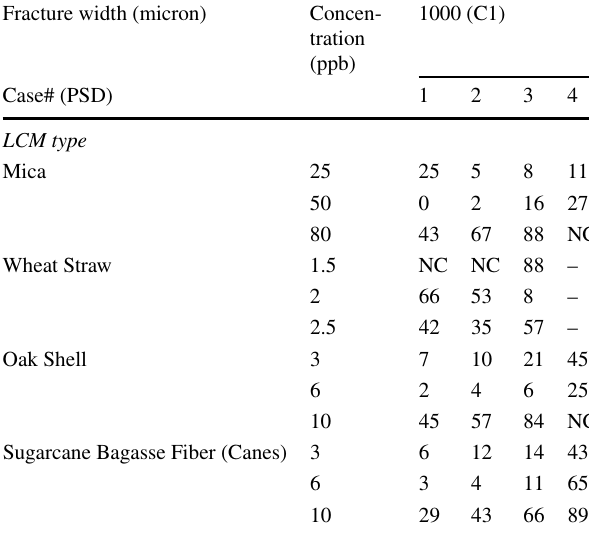
Table 5 LPA fluid loss results in (ml) for individual LCM Fracture width (micron) Concen- tration